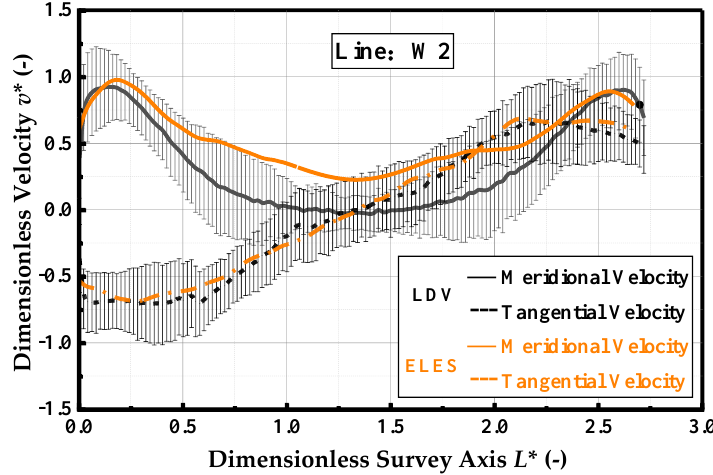
Figure 4. The velocity comparison between simulation and experiment. ( v * = v / v throat , where v is axial velocity or tangential velocity).